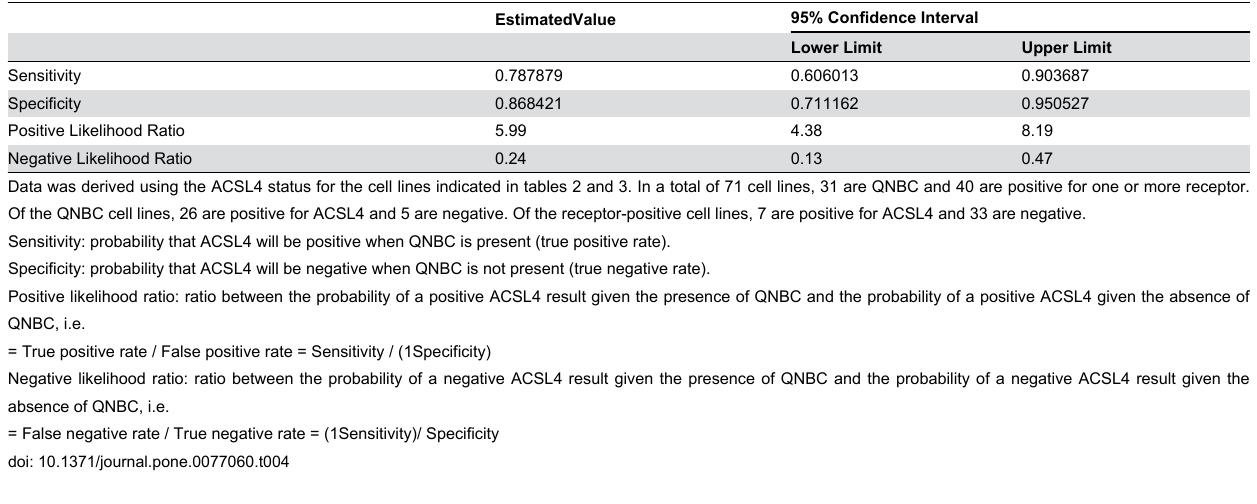
Table 5. Cell lines that are anomalies with respect to ACSL4 expression.